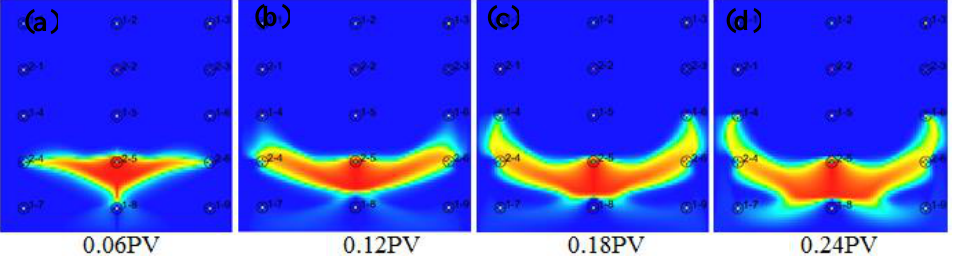
Figure 6. The polymer ( a ) injected, 0 PV, ( b ) injected, 0.045 PV, ( c ) injected, 0.09 PV, ( d ) injected, 0.135 PV, ( e ) injected, 0.18 PV, ( f ) injected, 0.225 PV, ( g ) injected, 0.27 PV, ( h ) injected, 0.315 PV, ( i ) injected, 0.36 PV, ( j ) injected, 0.405 PV, ( k ) injected, 0.45 PV, and ( l ) injected, 0.495 PV tracer diagrams of the well 1-5.